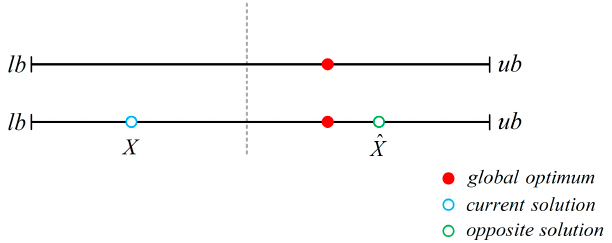
Figure 4. Principle of the traditional opposition-based learning.